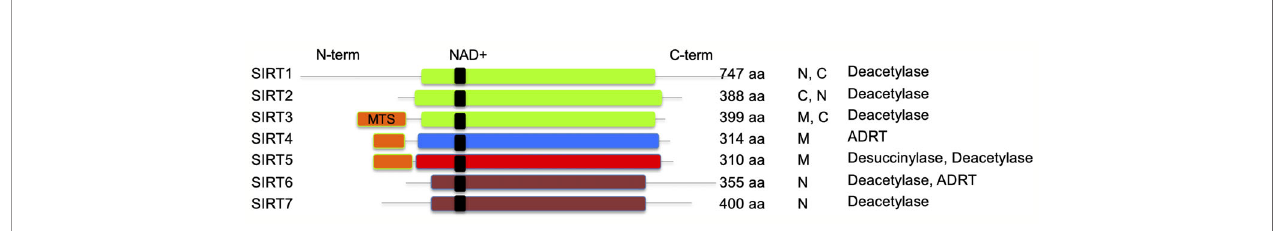
FIGURE 1 | Schematic representation of human sirtuins. SIRT1 – 3 (class I), SIRT4 (class II), SIRT5 (class III), and SIRT6 – 7 (class IV) are shown. NAD + binding region is presented in black. MTS, mitochondria-targeting sequence is shown in orange; N, nuclear; C, cytoplasmic; ADRT, ADP-ribosyltransferase. Catalytic histidine and zinc-coordinating cysteines are not